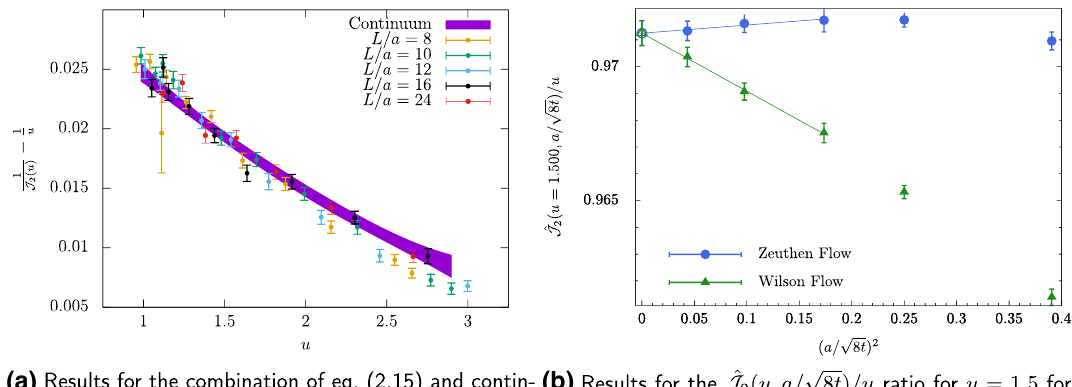
√ 8 t ) function and continuum extrapolation